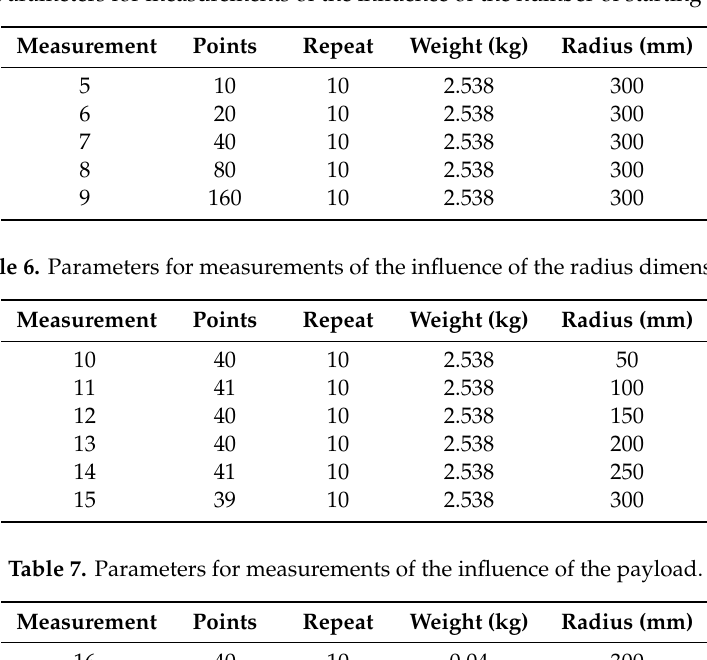
Table 5. Parameters for measurements of the influence of the number of starting positions.